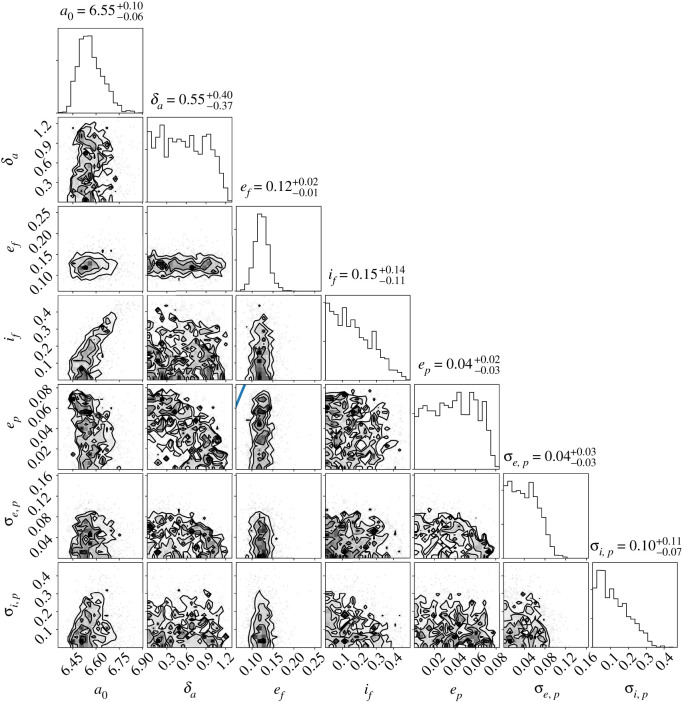
Posterior parameter distributions for the full model of the HD 202628 ring with a uniform range of semi-major axes. A line with ep = ef is shown in the appropriate panel, illustrating that the proper eccentricity is significantly lower than the forced eccentricity. Only parameters related to the eccentric disc model are shown here. Each off-diagonal panel shows the two-dimensional distributions, with 1, 2 and 3σ contours in regions of high density, and individual dots in regions of low density. The diagonal panels show the one-dimensional distributions.